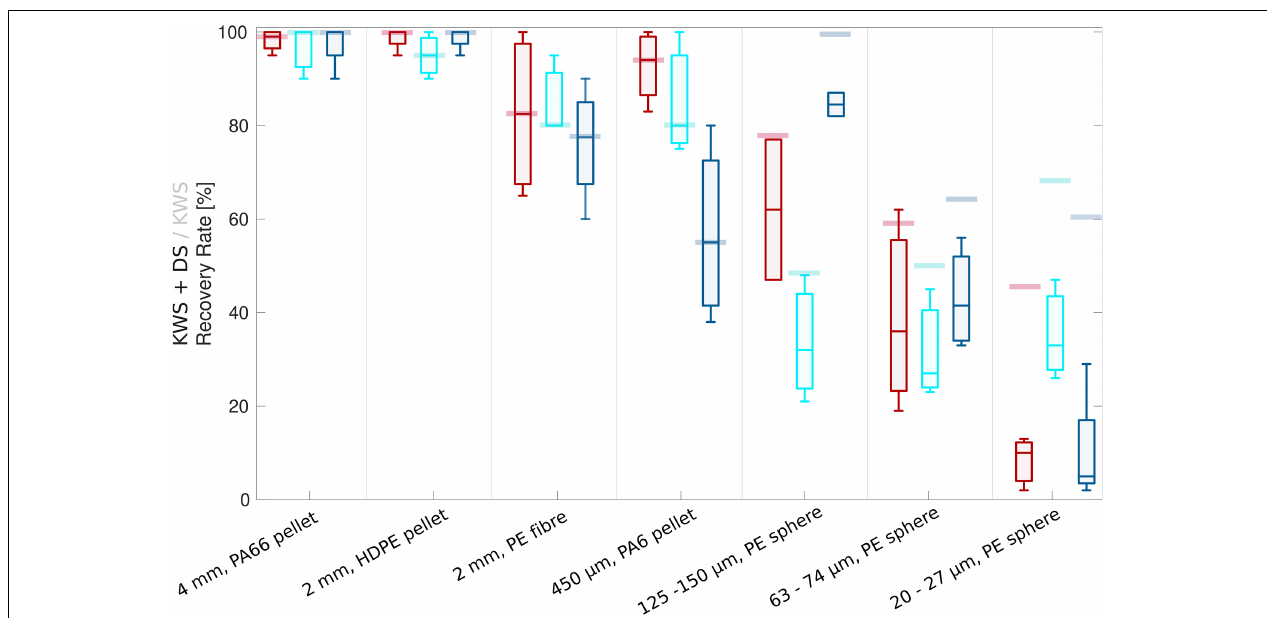
FIGURE 1 | Box plot series showing recovery rates (incl. density separation, DS) of MP of different size classes from beach sand (red), commercial sand (turquoise) and beach sand with additional presence of dust (dark blue). Whiskers represent the 25 and 75 percentiles. KWS-specific median recovery rates of MP of different size classes, mathematically corrected for density separation, are shown as opaque bars behind the box